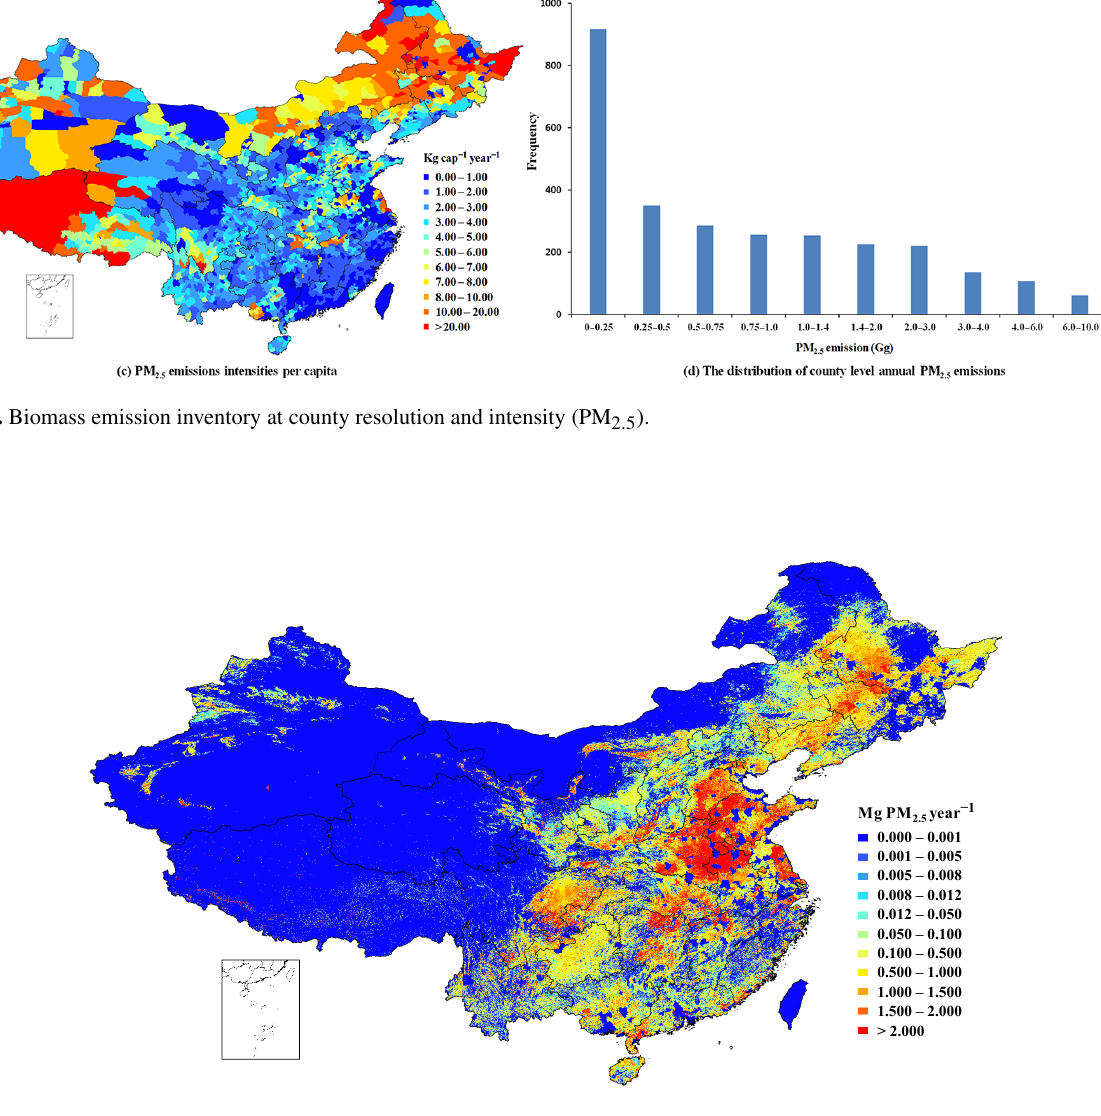
Figure 7. Gridded distribution of PM 2 . 5 annual